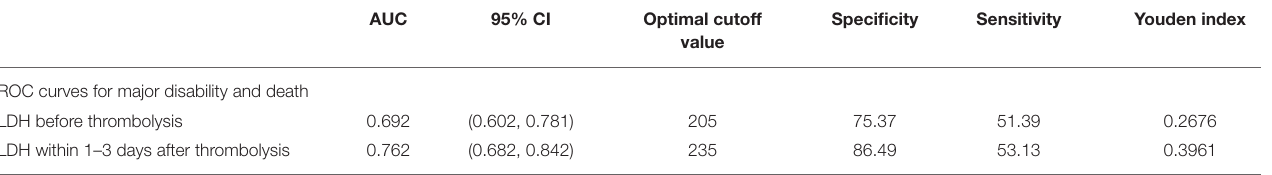
TABLE 5 | AUC for serum LDH levels before and within 1–3 days after thrombolysis of 3-month